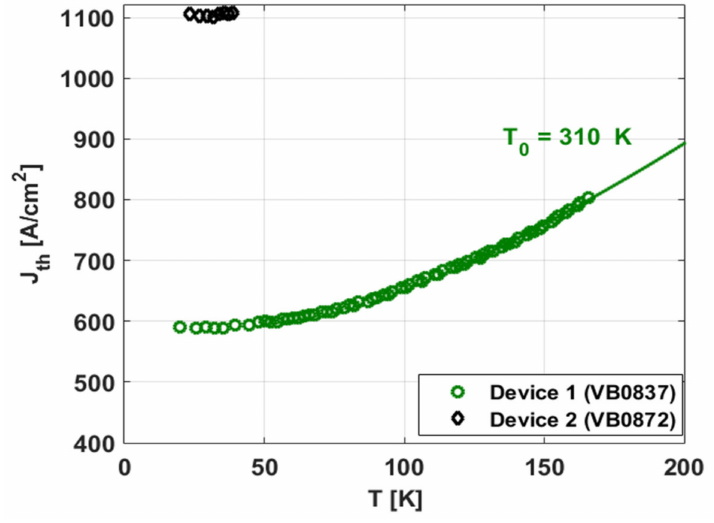
Figure 4. Plots of the SW–DP THz QCL devices’ threshold current versus